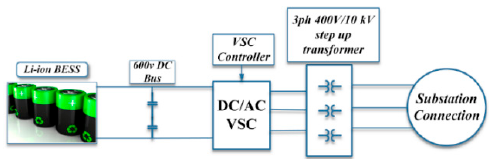
Figure 4. BESS grid integration topology.